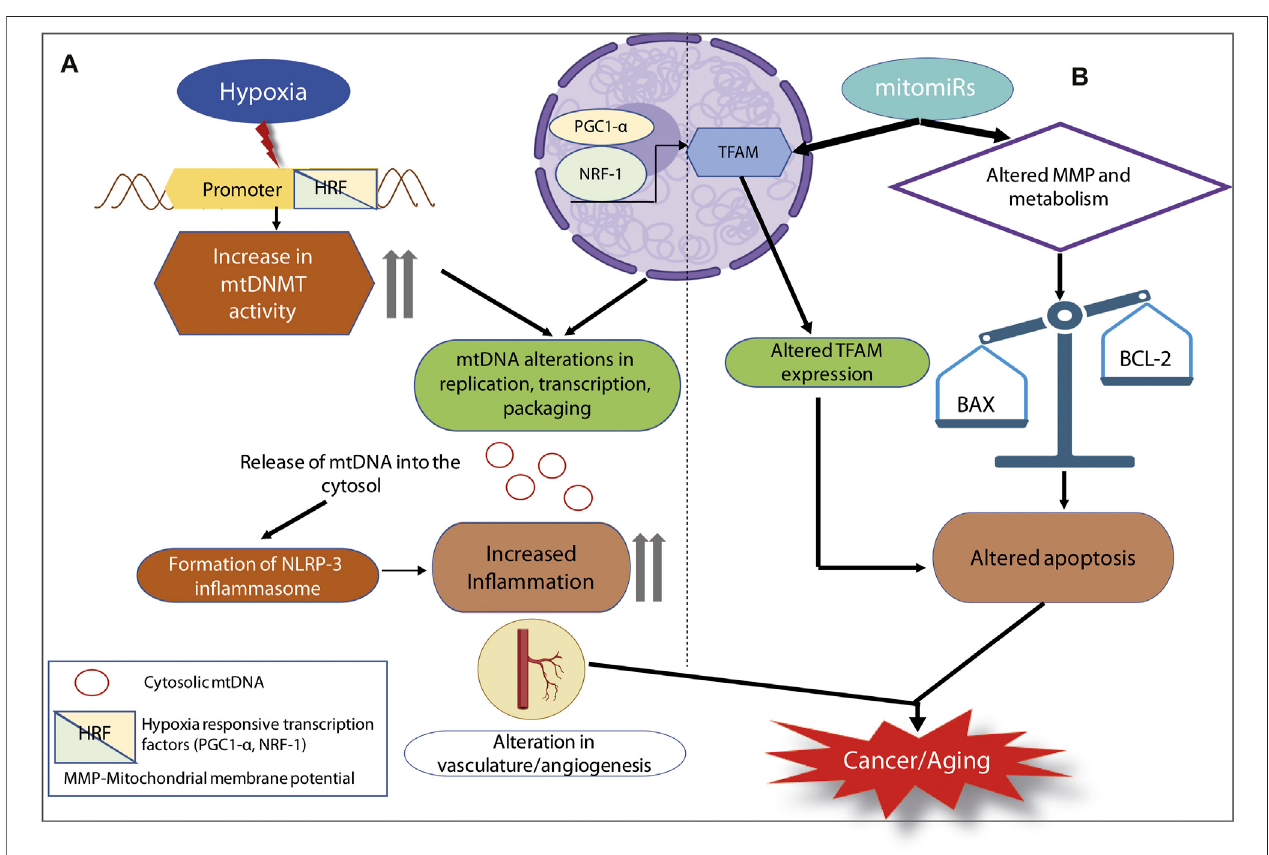
FIGURE2| Mitoepigeneticregulationofin fl ammationincanceroraging. (A) Hypoxiaasanoncogenicstimulus,itturnsontheHRFs.HRFsaltermtDNMTactivityas wellastheexpression ofTFAM. They cancombinatoriallyleadtoseveralmtDNAalterations andtherelease ofmtDNAintothecytosol.Extrusion ofcytosolicmtDNAcan trigger the formation of NLRP3 in fl ammosome, elevated in fl ammation culminating in cancer or aging. (B) mitomiRs are capable of altering TFAM expression as well as mitochondrial membrane potential and metabolic status. These two pathways can converge on the apoptotic fate of cell, thereby leading to cancer or aging.